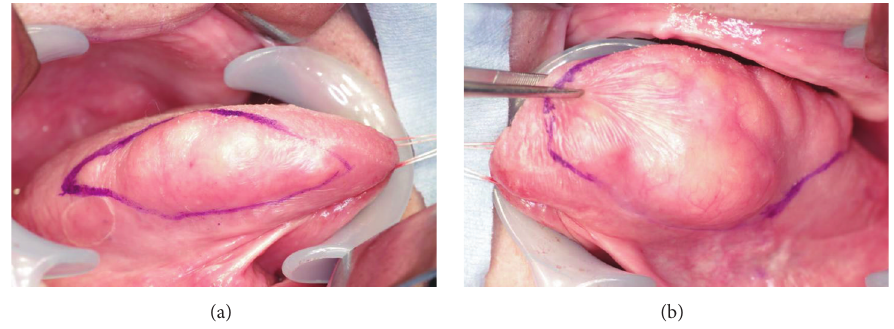
Figure 3: Intraoperative view. Surgical incision ((a) right side, (b) left side).